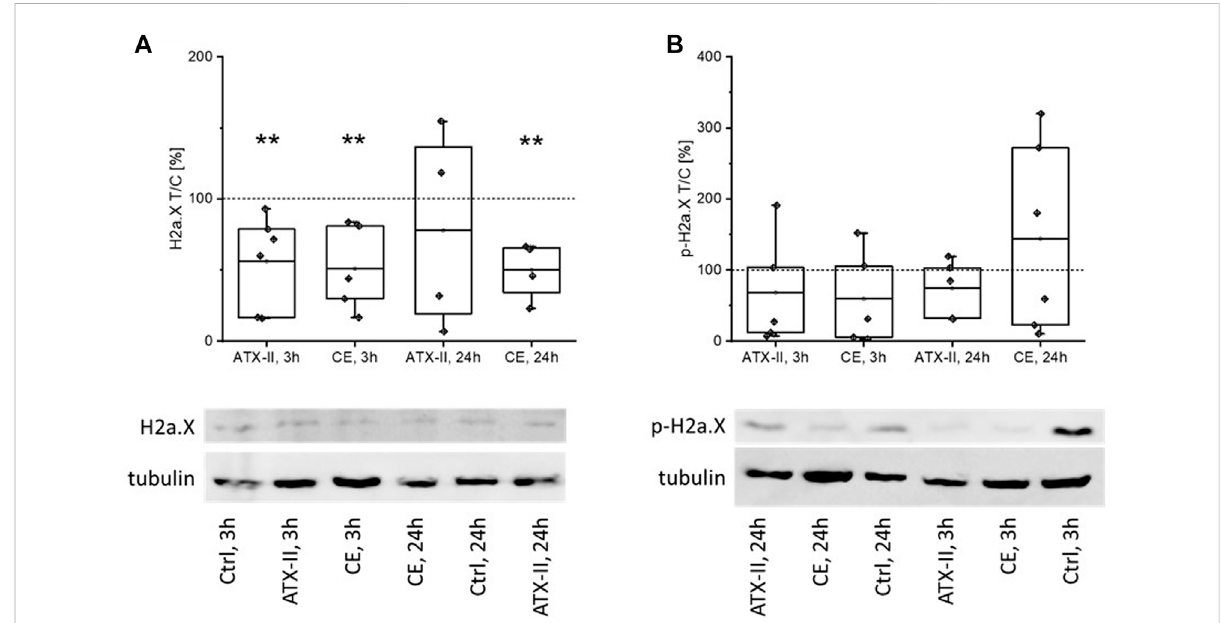
FIGURE 3 The impact of oral uptake of altertoxin-II (ATX-II) or a complex extract (CE) of Alternaria toxins on H2a.X phosphorylation and depletion in the liver of rats, at 3 h or 24 h after administration, as measured by SDS-PAGE/Western Blotting. (A,B) depict protein levels of H2a.X and its phosphorylated form, pH2a.X, respectively, as box blots and data points for thesingle rats. All data was normalized to the respective control (Ctrl) rat receiving the solvent that was analyzed in the same experiment, as indicated by dotted lines. Normal distribution of data was con fi rmed by Shapiro-Wilk testing. Signi fi cant differences to the control group were calculated using one-way ANOVA, followed by Fisher LSD post-hoc testing, and are indicated by “ ** ” ( p < 0.01). Directly below the graphs, representative images of Western blotting membranes are